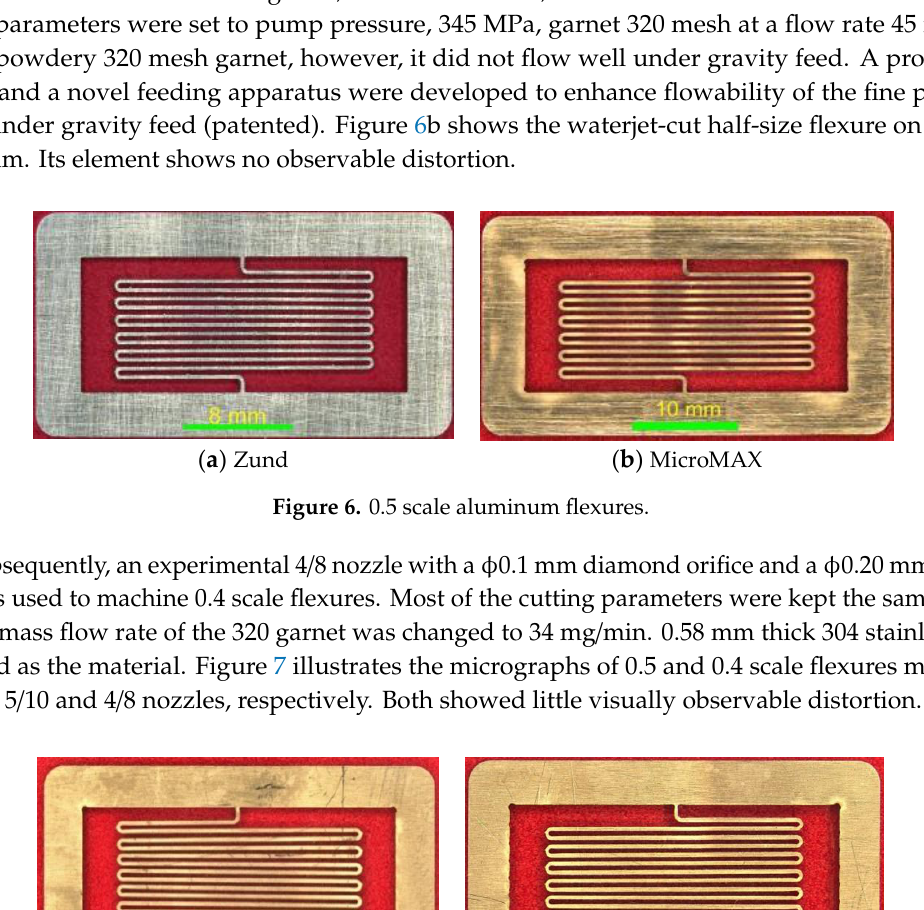
Figure 7.  AWJ-cut 0.5 and 0.4 scales stainless steel flexures (0.58 mm thick).